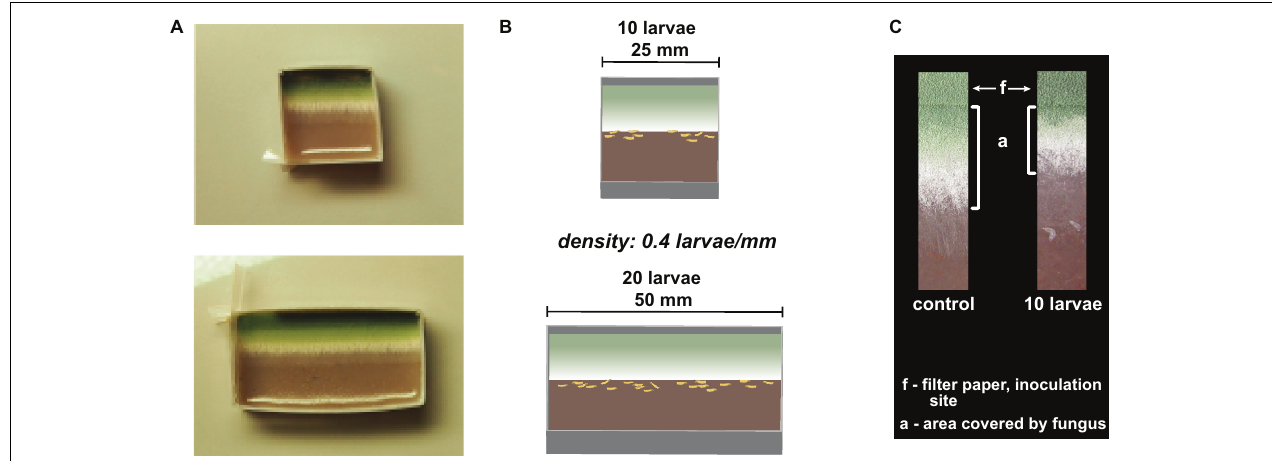
FIGURE 2 | Illustration of experimental setup. (A) Pictures of experimental arenas with unconfronted Aspergillus nidulans colonies. (B) Schematic drawing of the experimental arenas. (C) Sections of unidirectionally growing mold (from top to bottom) without (control) and with 10 larvae. The aging and the fruiting zones (top) are characterized by the development of increasingly greener conidiospores. The younger productive zone can be recognized by the formation of aerial whitish hyphae, while the hyphae of the outer zone lie flat on the fruit agar or are slightly embedded in it. The feeding activity of Drosophila larvae is largely restricted to this outer zone of the mycelium, which makes the mold colonies less invasive. “a” is the area of undamaged fungal tissue that we quantified; “f” is the area covered by the filter paper inoculated with conidia.